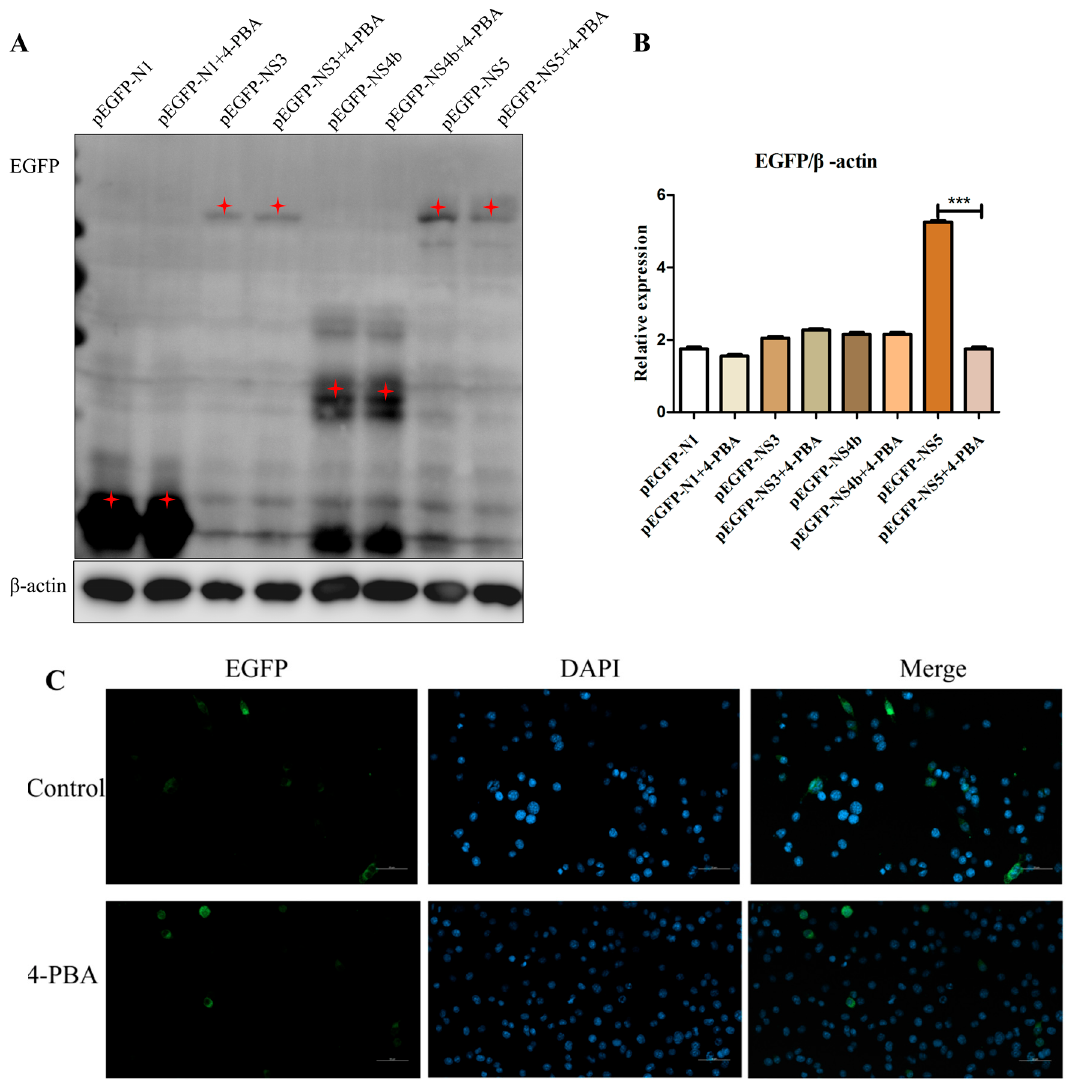
Figure 5. 4-PBA inhibits NS5 expression in vitro. ( A , B ) Effect of 4-PBA on the expression of NS3, NS4b and NS5 proteins. ( C ) Laser confocal microscope detected NS5 gene expression. The red star is the correct size of protein. *** p < 0.001.